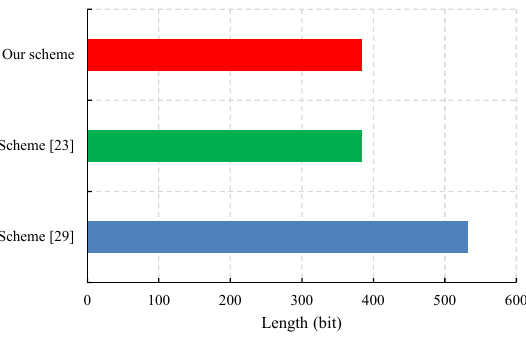
Figure 4. A comparison of the communication